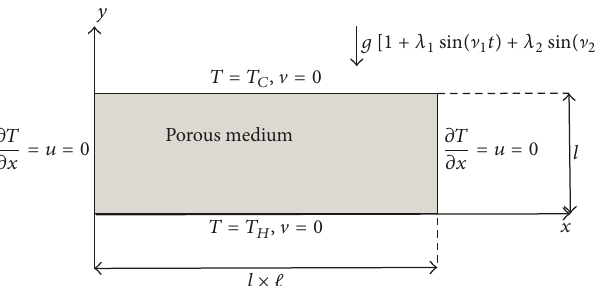
Figure 1: A two-dimensional rectangular porous domain heated from below subjected to two-frequency gravitational modulation.